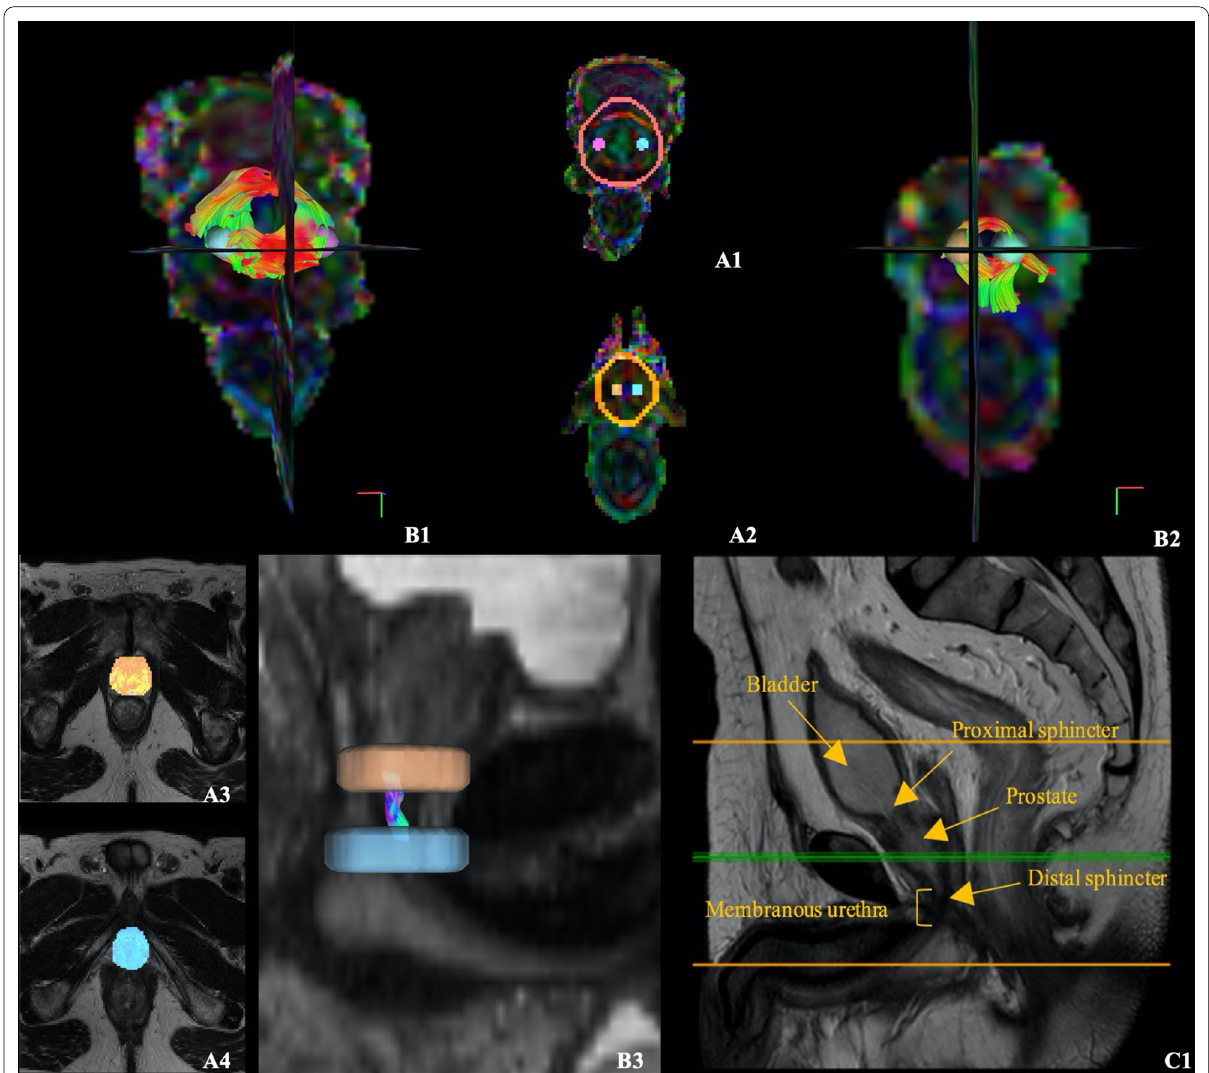
Fig. 2 Axial views obtained from DSI Studio showing the region of interest (ROI) placement on the color-coded FA maps for the proximal sphincter ( A1 ) and distal sphincter ( A2 ), and on the T2-weighted image for the apex ( A3 ) and bulb ( A4 ) to track the membranous urethra. Fiber tracking results derived from the DTI images of an arbitrarily chosen study patient are shown for the proximal sphincter ( B1 ), distal sphincter ( B2 ), and membranous urethra ( B3 ), color-coded based on the direction of the fibers—red for left–right (x), green for anterior–posterior (y), and blue for superior-inferior (z) directions. MRI T2-weighted image of a patient’s mid-sagittal slice labelled with the relevant anatomy, where the orange lines define the proximo-distal extent imaged in the DTI acquisition ( C1